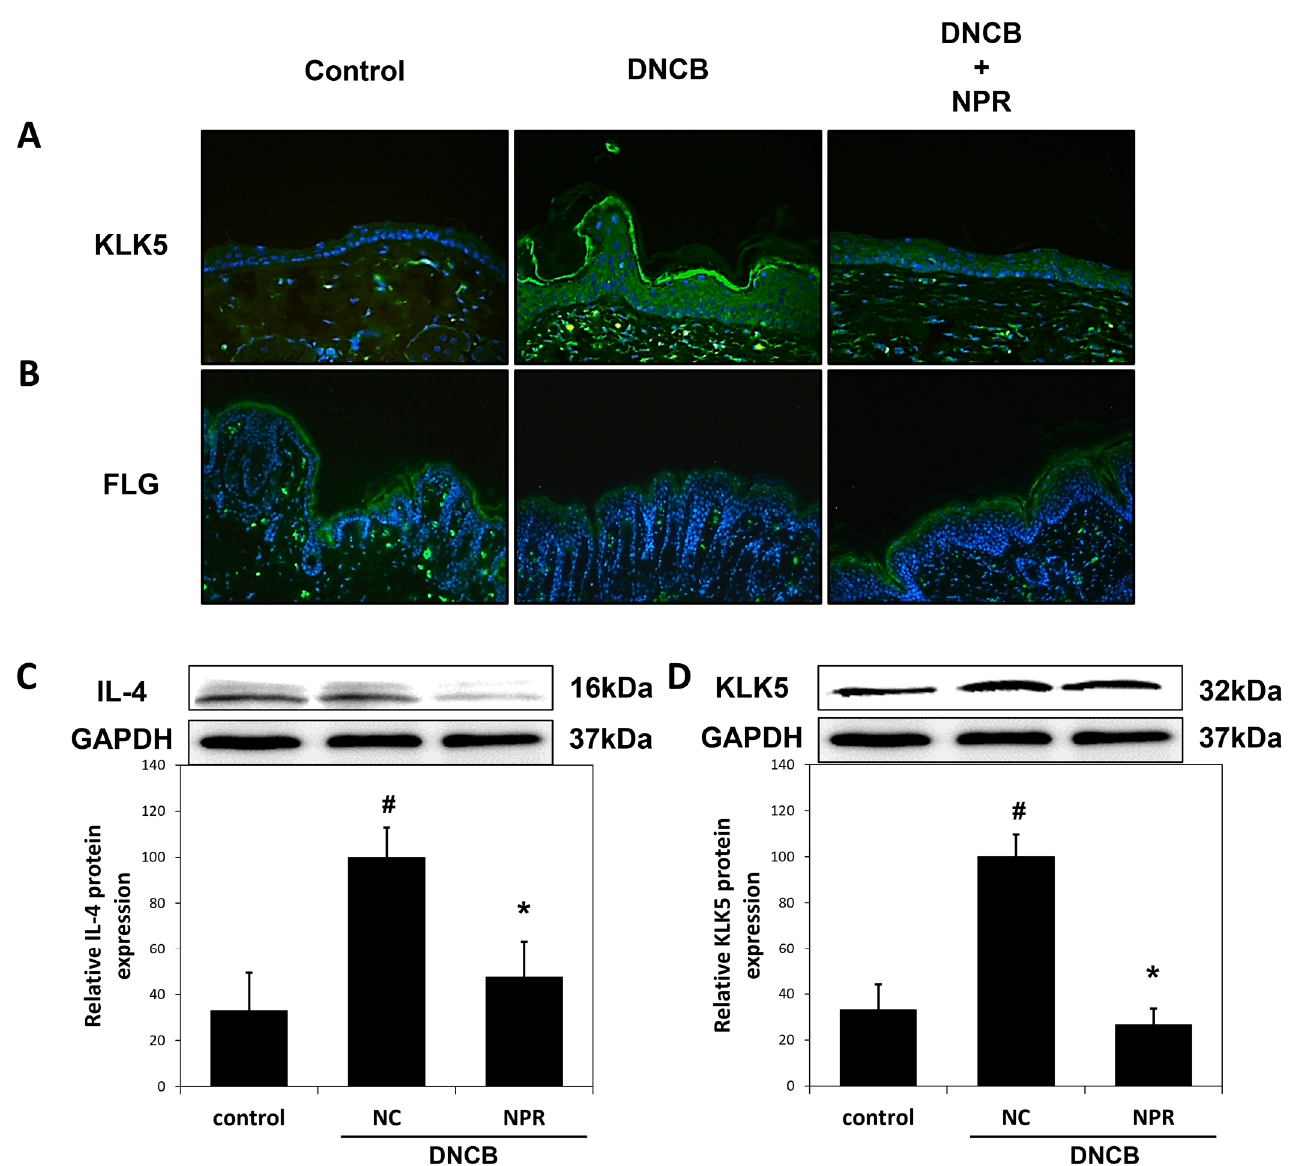
Figure 5. Effects of NPR extract on skin barrier function-associated proteins. ( A , B ) Immunohisto- chemical staining of FLG and KLK5, and ( C , D ) immunoblotting to determine IL-4 and KLK5 protein levels (normalized vs. GAPDH). Results are expressed as the means ± SE of 2 to 3 independent experiments. # p < 0.05 vs. untreated control group; * p < 0.05 vs. DNCB-treated mice. control: untreated control group; NC: DNCB-treated negative control group; NPR: DNCB plus N. peltata root extract-treated group.